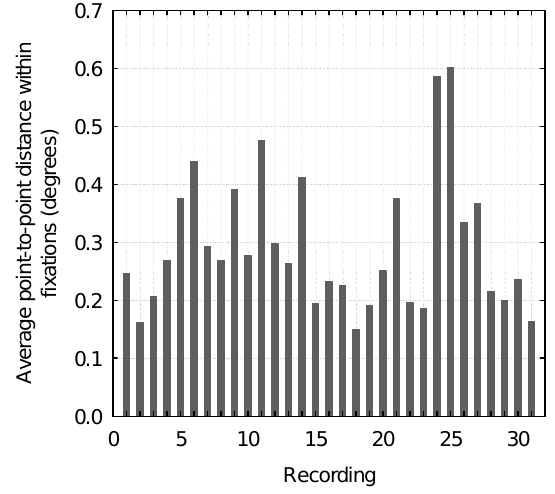
Figure 3: Average point-to-point distance within fixations per participant recording. The average point-to-point velocity can be obtained by multiplying the distance with 50, i.e. the frequency of the eye-tracker that was used.